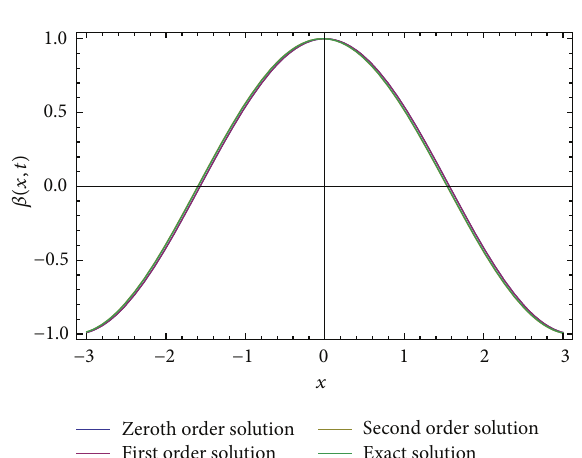
Figure 17: 2D, residual of 𝜂(𝑥,𝑡) at 𝑡 = 0.1 .